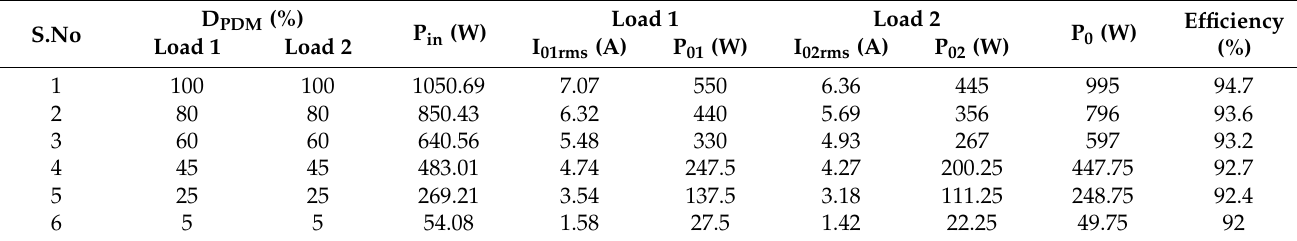
Table 3. Efficiency for various D PDM.